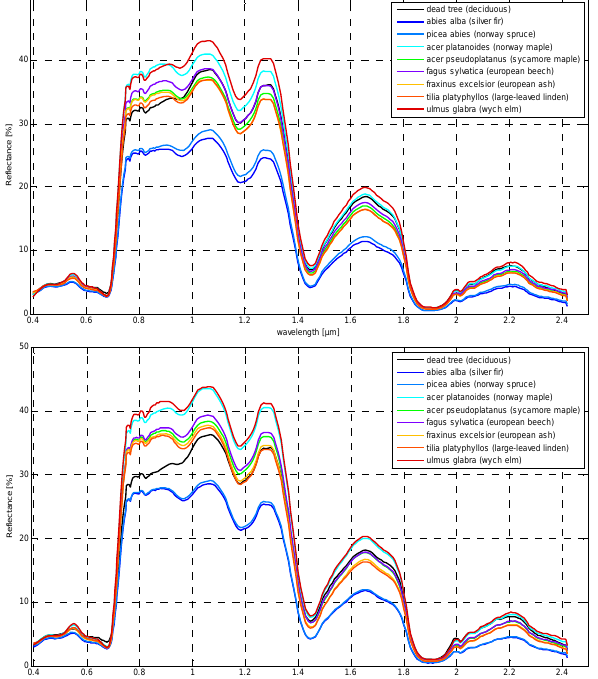
Figure 5. Reflectance spectra of (up) different species computed using original field inventory data and (down) matched field data to ALS-derived crowns, which computed from sunlit part of the crowns